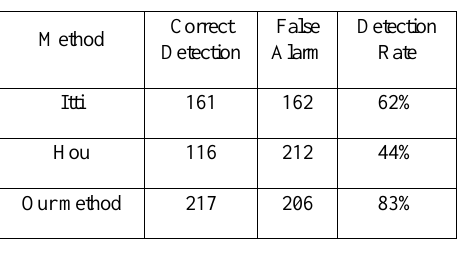
Tab 1. Compared results of different